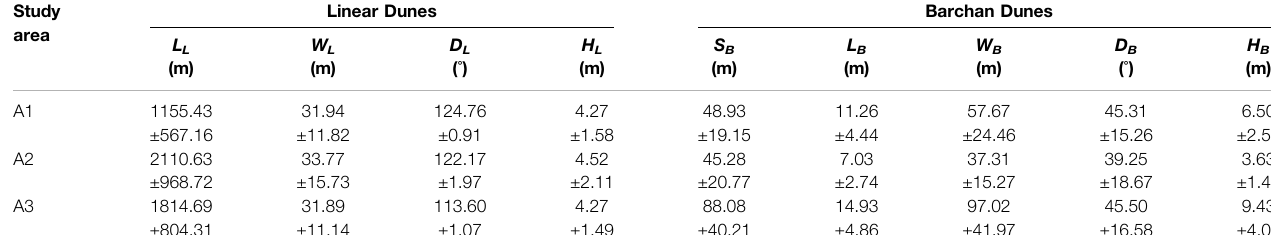
TABLE 1 | The morphological characteristics of the linear and barchan dunes. Values are means ± SD (n = 17, 41, and 35 for linear dunes in areas A1, A2, and A3, respectively,andn=34,98,and86forbarchandunesinareasA1,A2,andA3,respectively;themorphologicalcharacteristicsincludingcrest-linelength( L